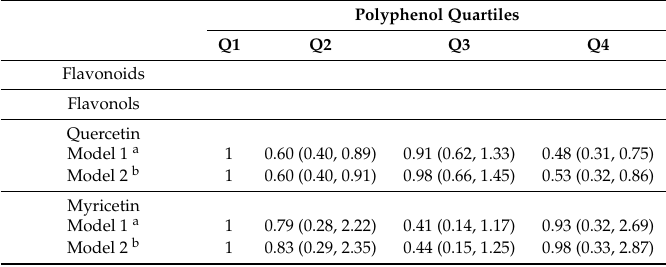
Table 4. Odds ratios (ORs) and 95% confidence intervals (CIs) for the association between individual phenolic compounds and depressive